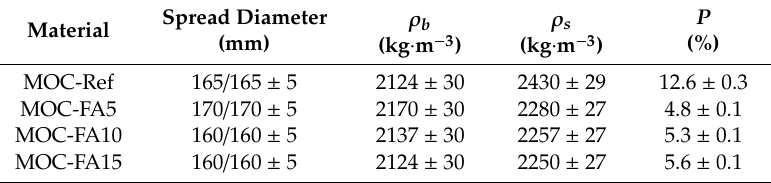
Table 4. Workability and basic structural parameters of developed composites.